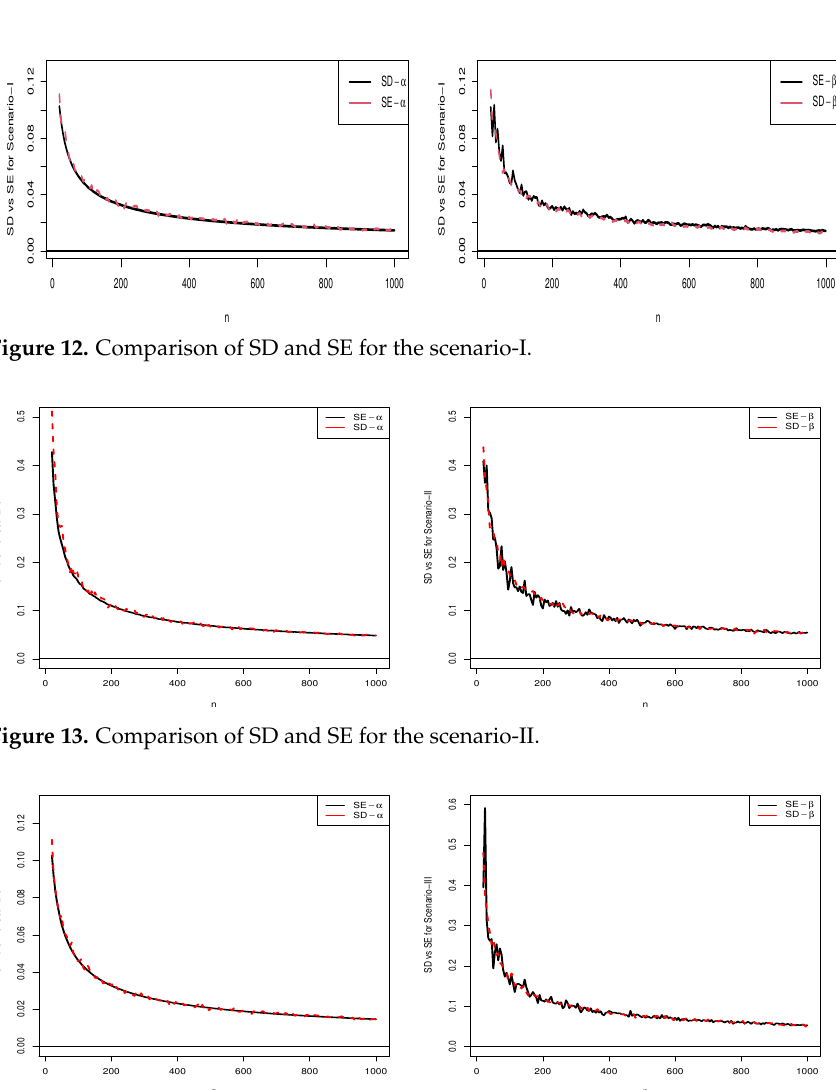
Figure 14. Comparison of SD and SE for the scenario-III.